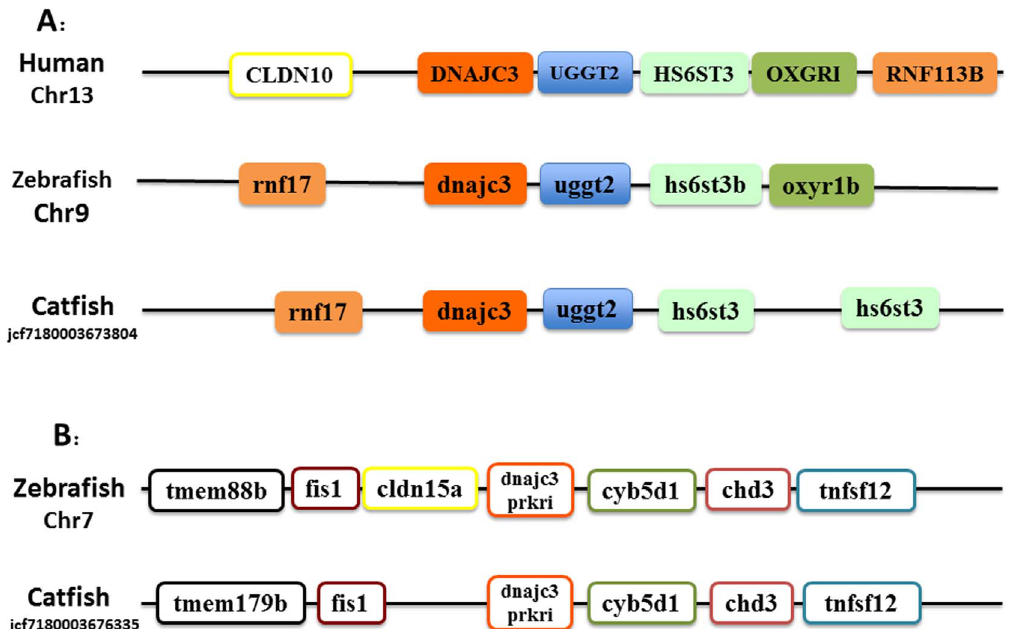
Fig. 3. Schematic presentation of the conserved synteny blocks neighboring DnaJc3 (A) and DnaJc3-prkri gene (B). Note that in each case, the gene order and orientation was relatively conserved. Abbreviations: (A) CLDN10, claudin 10; rnf17, ring finger protein 17; DnaJc3, DnaJ (Hsp40) homolog, subfamily C, member 3; uggt2, UDP-glucose glycoprotein glucosyltransferase 2; hs6st3b, heparan sulfate 6-O-sulfotransferase 3b; oxyr1b, oxoglutarate (alpha-ketoglutarate) receptor 1b; RNF113B, ring finger protein 113B. (B) tmem88b, transmembrane protein 88 b; fis1, fission 1 (mitochondrial outer membrane) homolog (S. cerevisiae); cldn15a, claudin 15a; dnajc3 prkri, protein-kinase, interferon-inducible double stranded RNA dependent inhibitor; cyb5d1, cytochrome b5 domain containing 1; chd3, chromodomain helicase DNA binding protein 3; tnfsf12, tumor necrosis factor (ligand) superfamily, member